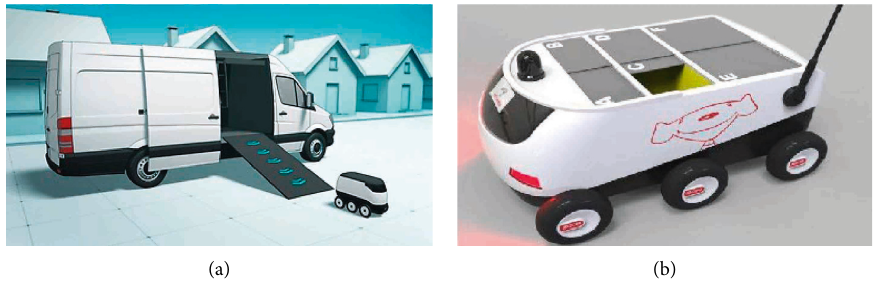
Figure 1: UV examples that are developed by companies. (a) The “mothership approach” in the project “Vans & Robots,” which was launched at Mercedes-Benz Vans in the Future Transportation unit (https://www.daimler.com/innovation/specials/future-transportation- vans/parcel-carrier-2-0.html). (b) A UV that was developed by JD e-business